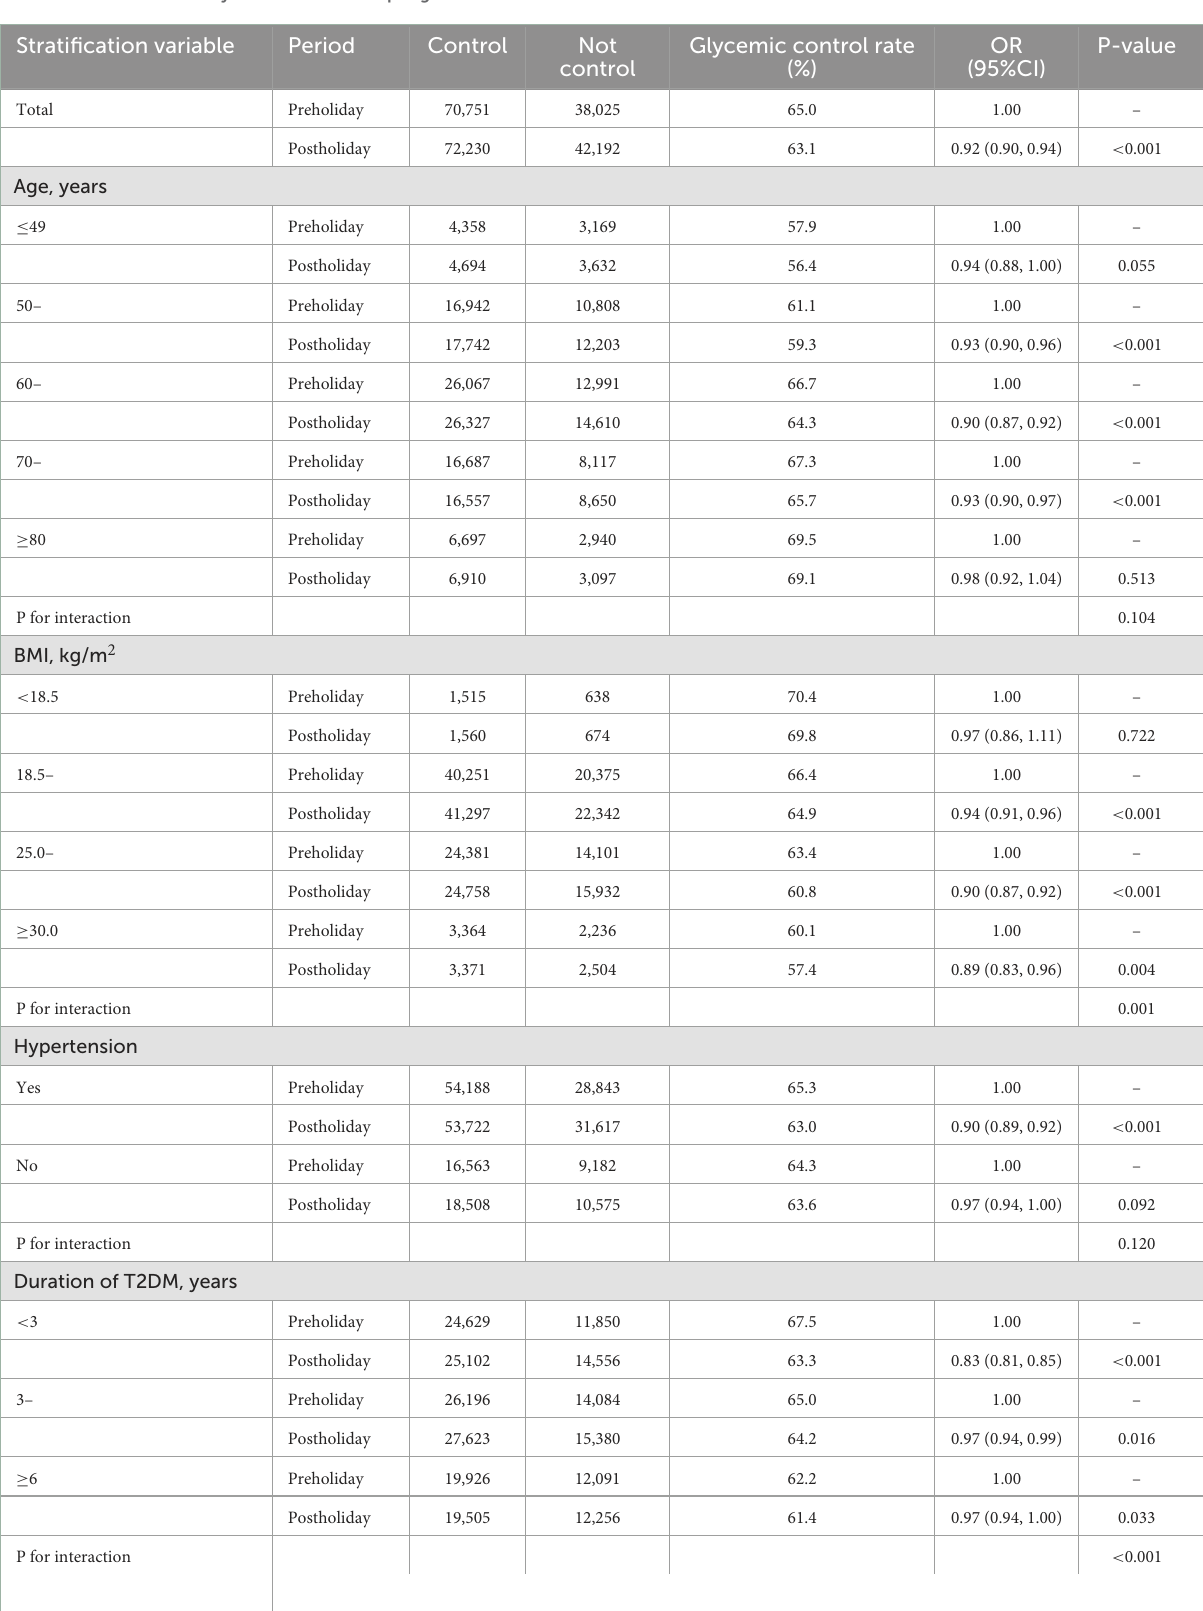
TABLE 2 Stratification analysis of the Chinese Spring Festival